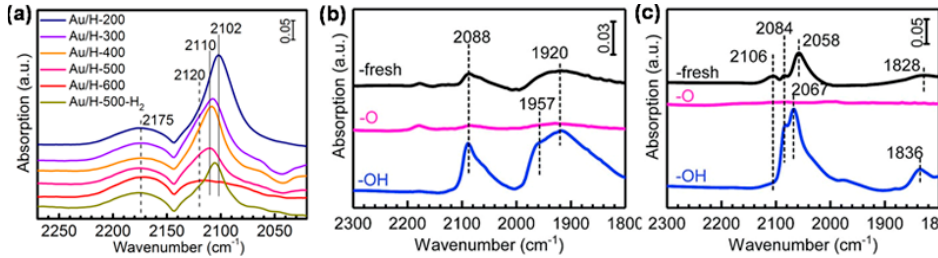
Figure 3. ( a ) In situ DRIFT spectra of CO adsorption on Au/H-X (H: HAP; X: the calcination temperature) and Au/H-500-H 2 (obtained by further reducing Au/H-500 at 500 °C); the bands at 2175 and 2120 cm − 1 can be assigned to the gas CO. Reproduced with permission from [45], copyright: 2016 by the American Chemical Society. ( b , c ) In situ DRIFT spectra of CO adsorption on ( b ) Pd/HAP and ( c ) Pt/HAP samples. “-fresh” represents the freshly synthesized samples without calcination, “-O” represents samples calcined under 10 vol% O 2 /He flow at 500 °C, “-OH” represents samples further reduced under 10 vol% H 2 /He flow at 250 or 500 °C for Pd/HAP and Pt/HAP, respectively. Reproduced with permission from [46], copyright: 2018 by The Royal Society of Chemistry.